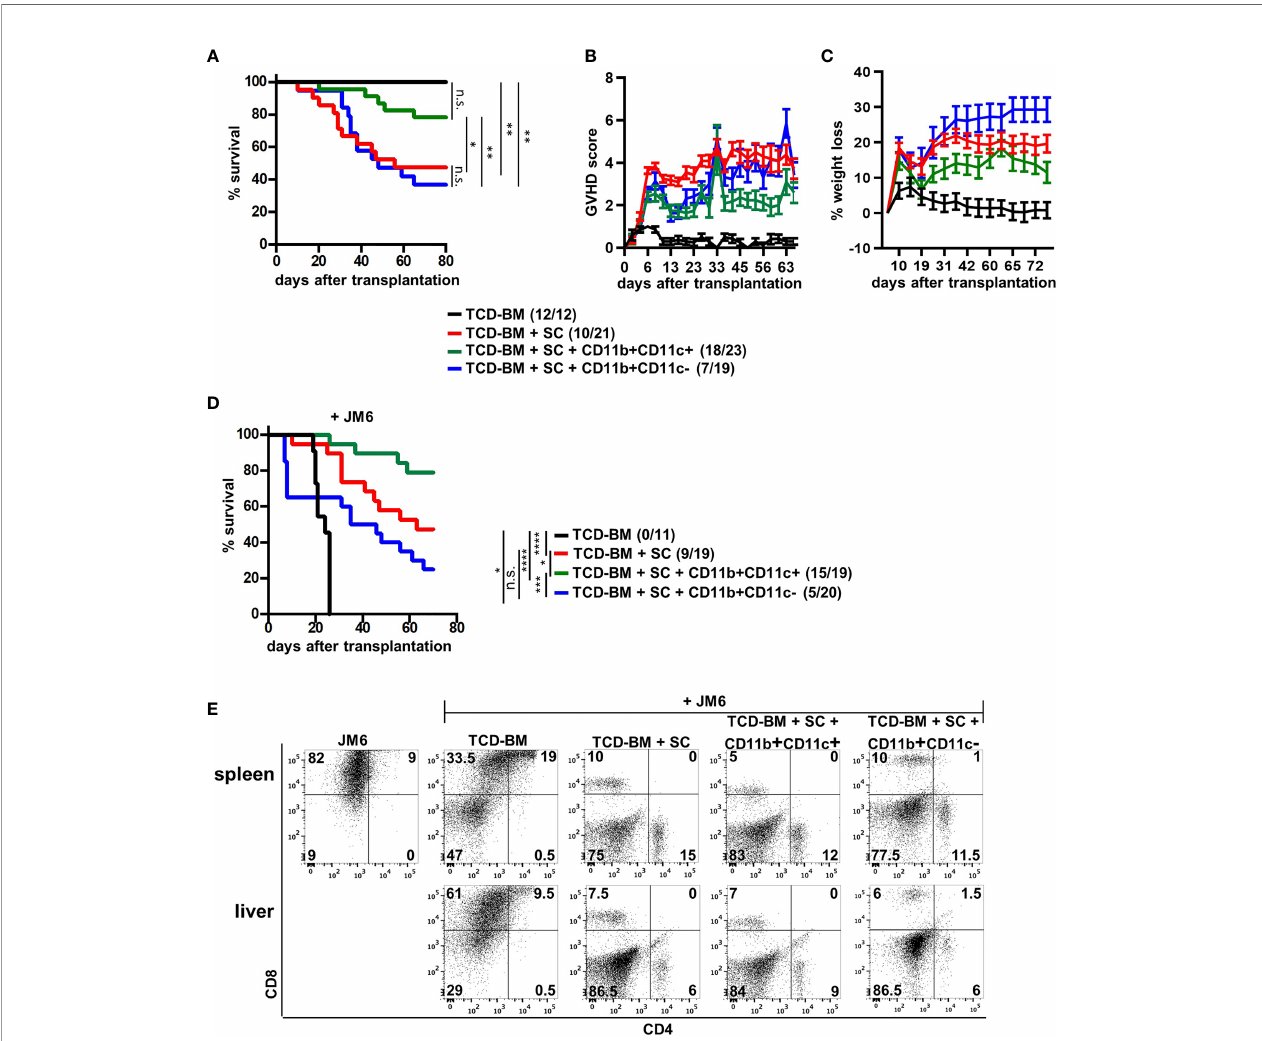
FIGURE 3 | CD11b+CD11c+ expression de fi nes the subpopulation of MDSCs able to prevent GVHD without disabling the GVT effect. (A – E) Lethally irradiated B6.bm1 mice (H-2K bm1 ) were reconstituted with B6-derived (H-2K b ) TCD-BM and SCs with or without B6-derived CD11b+CD11c+ or CD11b+CD11c − MDSCs. (D, E) Mice were additionally coinjected with the CD8+CD4 − syngeneic thymoma tumor cell line JM6 at day of transplantation. (A, D) Survival was determined. Surviving animals/total animals treated are indicated in brackets. (B) Clinical GVHD scores (C) and percentage of weight loss were determined. (E) Presence of tumor cells was analyzed in spleens and livers by staining for CD4 and CD8 at day mice were sacri fi ced due to their moribund state or at the end of the experiment. (A, C) Kaplan-Meier method and Log-rank test. (B, C) Data represent the mean value ± SEM. (D) Representative FACS diagrams of one mouse/group are displayed. * p ≤ 0.05; ** p ≤ 0.01; *** p ≤ 0.001; **** p ≤ 0.0001; n.s., not signi fi